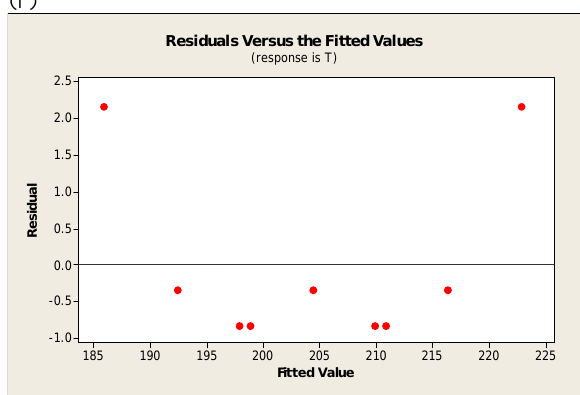
Fig. 5 . Residuals vs. fitted values for cutting force (F) Fig. 6. Residuals vs. fitted values for cutting temperature